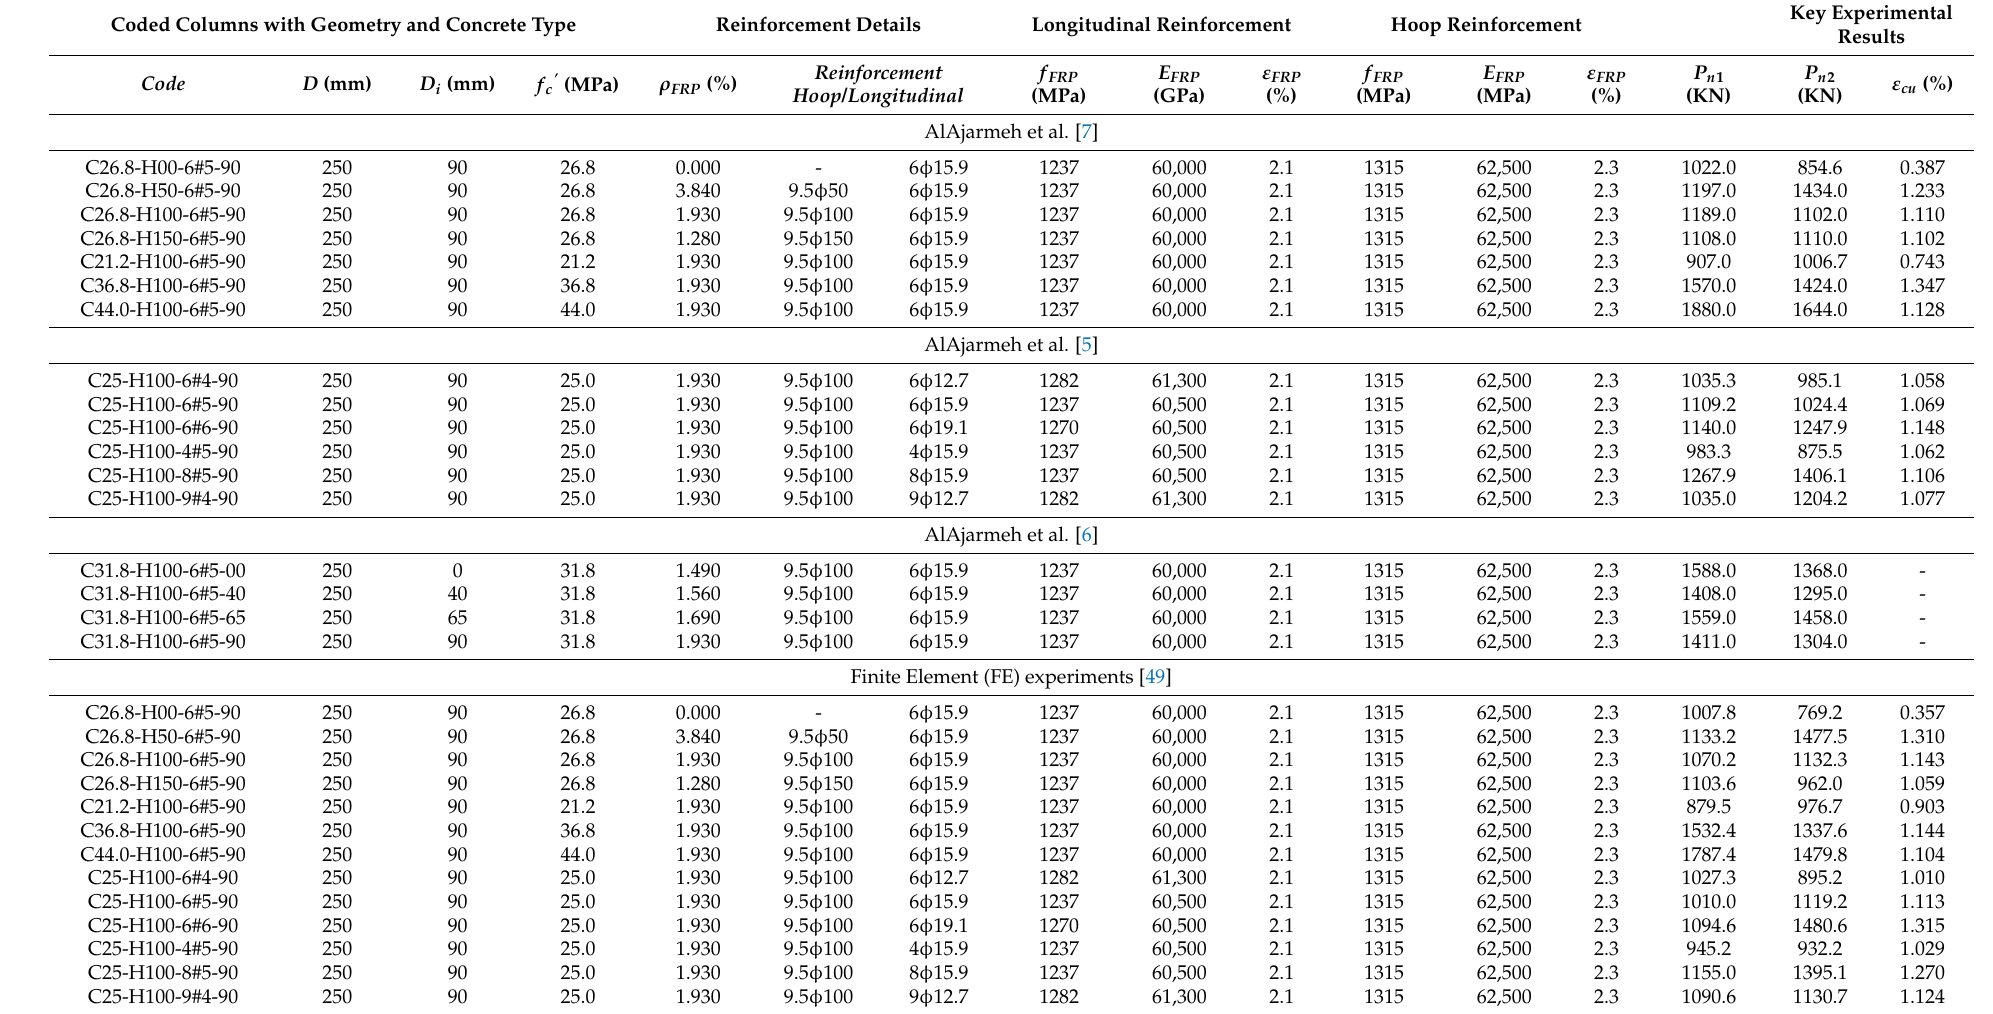
Table 2. Test database of GFRP-RC